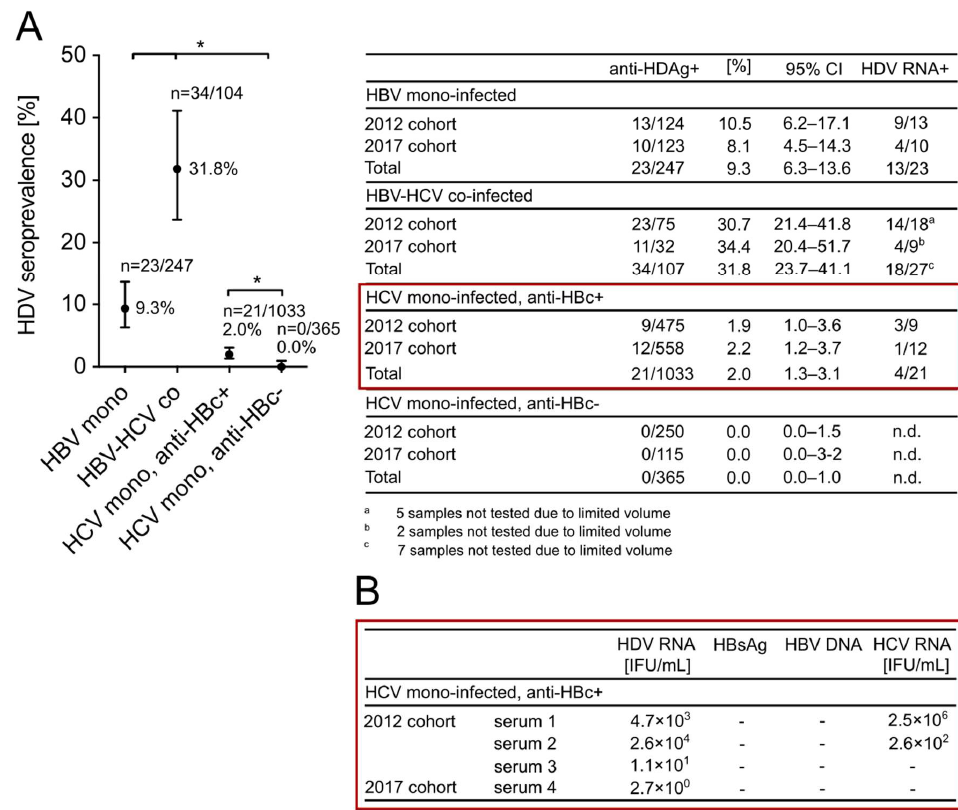
Figure 4. HDV seroprevalence in a Chinese high-risk population (Fuyu, Jilin province) known for abundant needle sharing during IVDU. Serum samples were collected in 2012 and 2017 and pre-characterized for HBsAg and anti-HCV during previous epidemiological studies conducted at the First Hospital of Jilin University (Jilin province, China). ( A ) Serological analysis for anti-HDV-Ab in Fuyu. Sera were retrospectively tested for anti-HDV-Ab using the HDV rapid test. Active HDV RNA replication was confirmed using the INSTANT Virus RNA/DNA Kit (Analyik Jena, Jena, Germany) for RNA extraction and the RoboGene HDV RNA Quantification Kit 2.0 (RoboScreen, Leipzig, Germany) on the 7500 Fast Instrument (Applied Biosystems, Foster City, USA) for RNA quantification. ( B ) Further characterization of HDV RNA-positive sera in the HBsAg-negative, anti-HBc-positive, anti-HCV-positive cohort. Sera were tested for quantitative HBsAg (Elecsys ® HBsAg II quant II kit, Roche, Basel, Switzerland), HBV DNA, and HCV RNA (COBAS AmpliPrep/COBAS TaqMan HBV and HCV Tests, Roche, Basel, Switzerland). CIs of 95% were calculated according to the Wilson score interval and seroprevalences were compared using the Chi-squared test. * corresponds to a p -value <